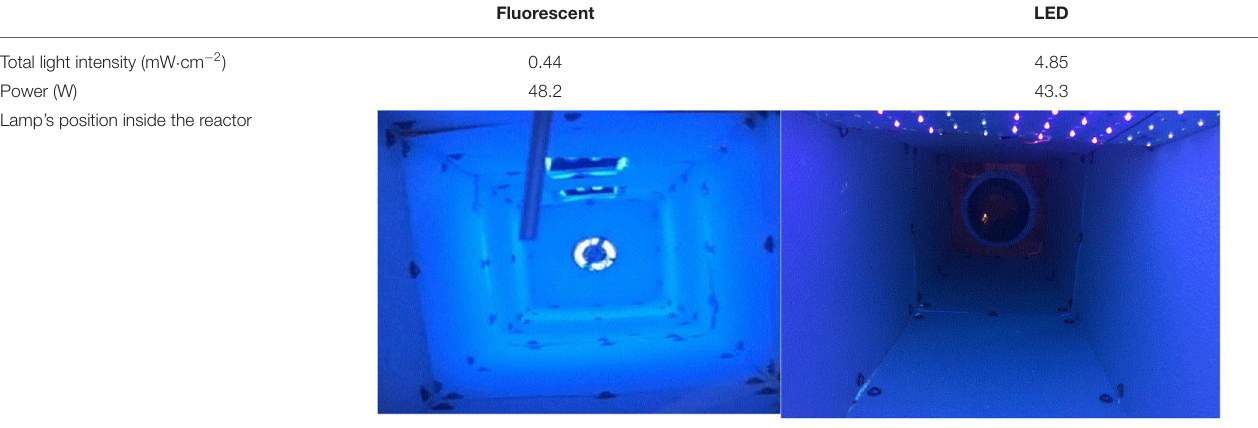
TABLE 2 | Comparison of experimental UV-A lamps.